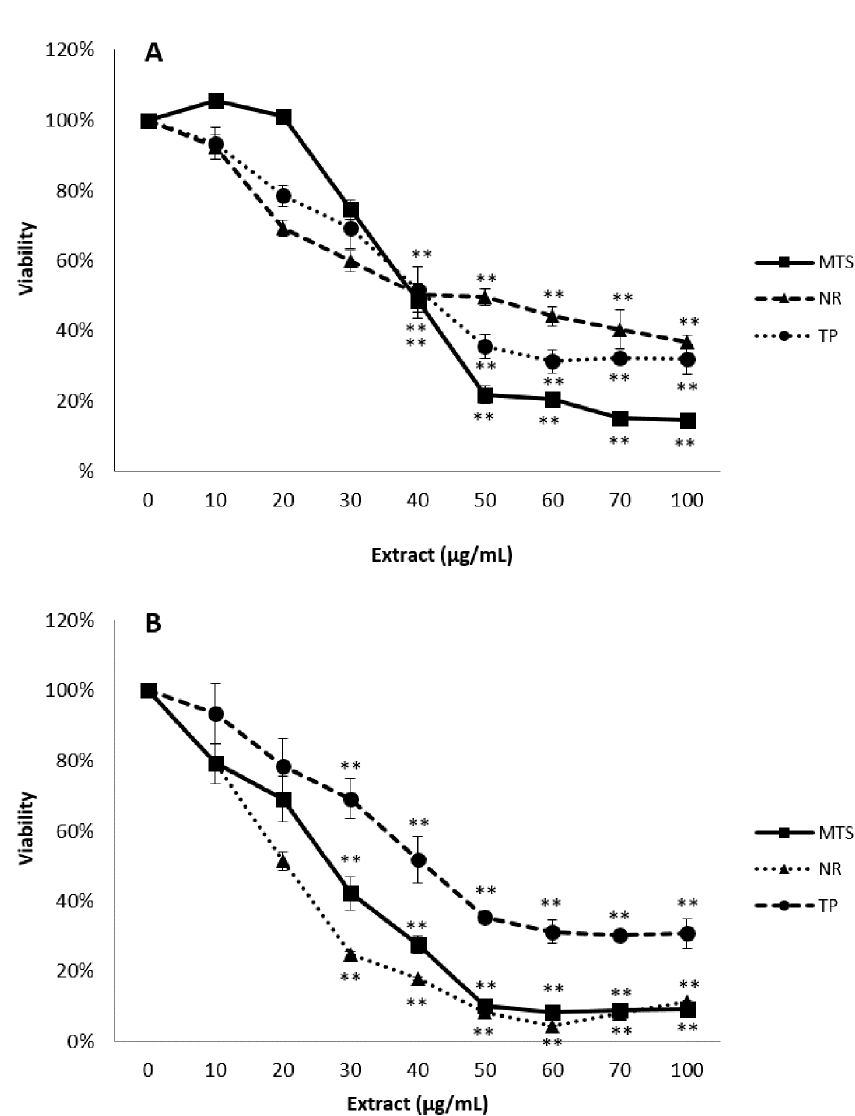
Figure 1. Reduction of tetrazolium salt (MTS), neutral rep uptake (NR), and total protein content (TP) of HepG2 cells exposed for 24 h ( A ) and 48 h ( B ) to 0–100 µ g / mL of the stilbene extract (45%). All values expressed as mean ± SD. Significant differences in respect to the control from p < 0.01 (**). After the exposure of Caco-2 cells to the extract, all assays showed similar concentration-dependent reduction in cell viability. MTS assay indicated a marked reduction in the cellular viability, being the EC 50 value in this endpoint of 55.8 ± 4.0 µ g / mL and 39.0 ± 2.7 µ g / mL after 24 h and 48 h, respectively. above at 24h, but when cells were exposed to the extract for two days, the cell viability was significantly reduced from 30 µ g / mL (Figure